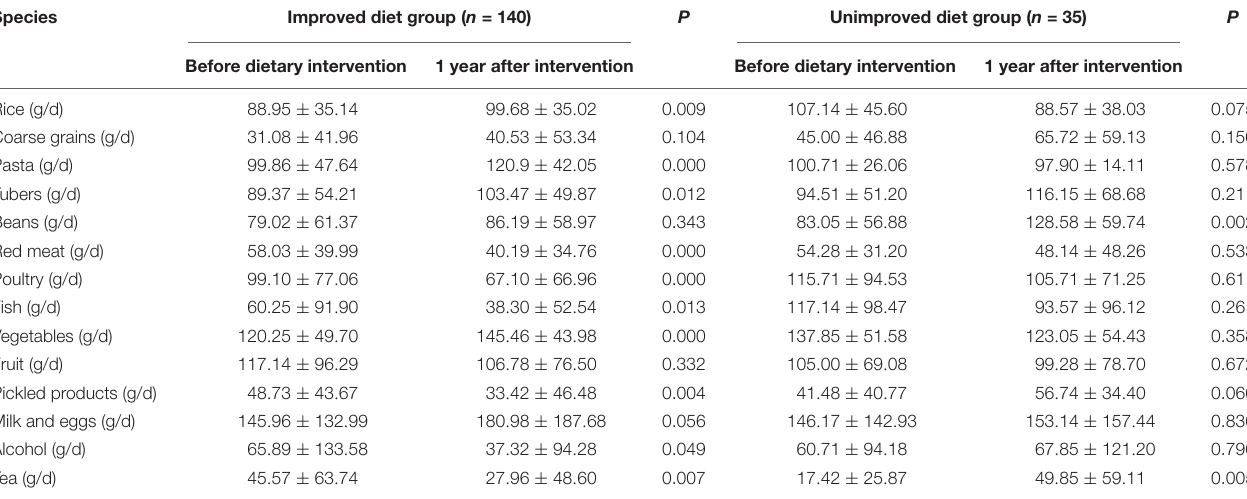
TABLE 7 | Dietary changes in the diet improvement group and the diet non-improvement group. Species Improved diet group ( n = 140) P Unimproved diet group ( n = 35) P Before dietary intervention 1 year after intervention Before dietary intervention 1 year after